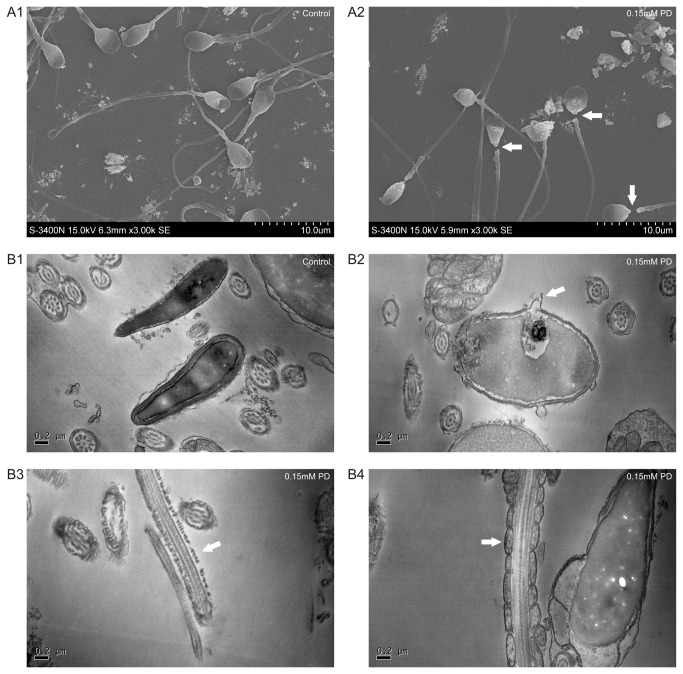
The microscopic ultrastructural changes in the sperm.Scanning electron microscopy (SEM) (A) and transmission electron microscopy (TEM) (B) images of untreated and PD-treated sperm. Normal sperm showing an intact membrane (A1), and 0.15 mM PD-treated sperm showing the detachment of heads (A2, arrows). Control sperm in the absence of PD showed intact membranes (B1), whereas the 0.15 mM PD-treated sperm showed membrane pore formation (B2, arrow), a missing tail membrane (B3, arrow) and swollen mitochondria (B4, arrow).